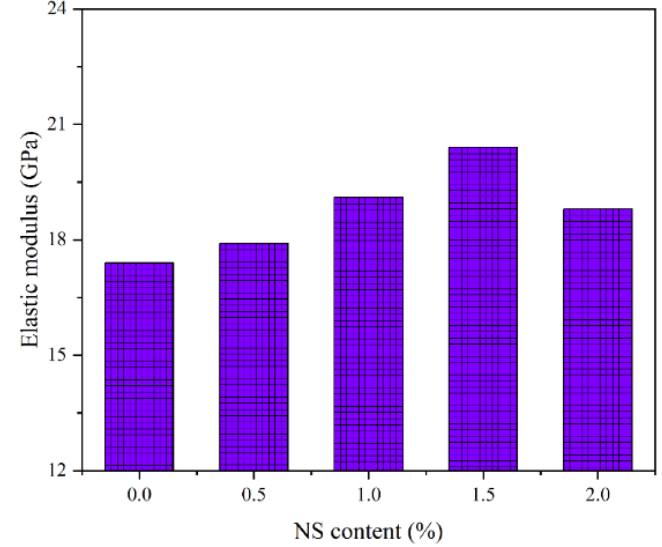
Figure 9. The elastic modulus of NS–GPC.